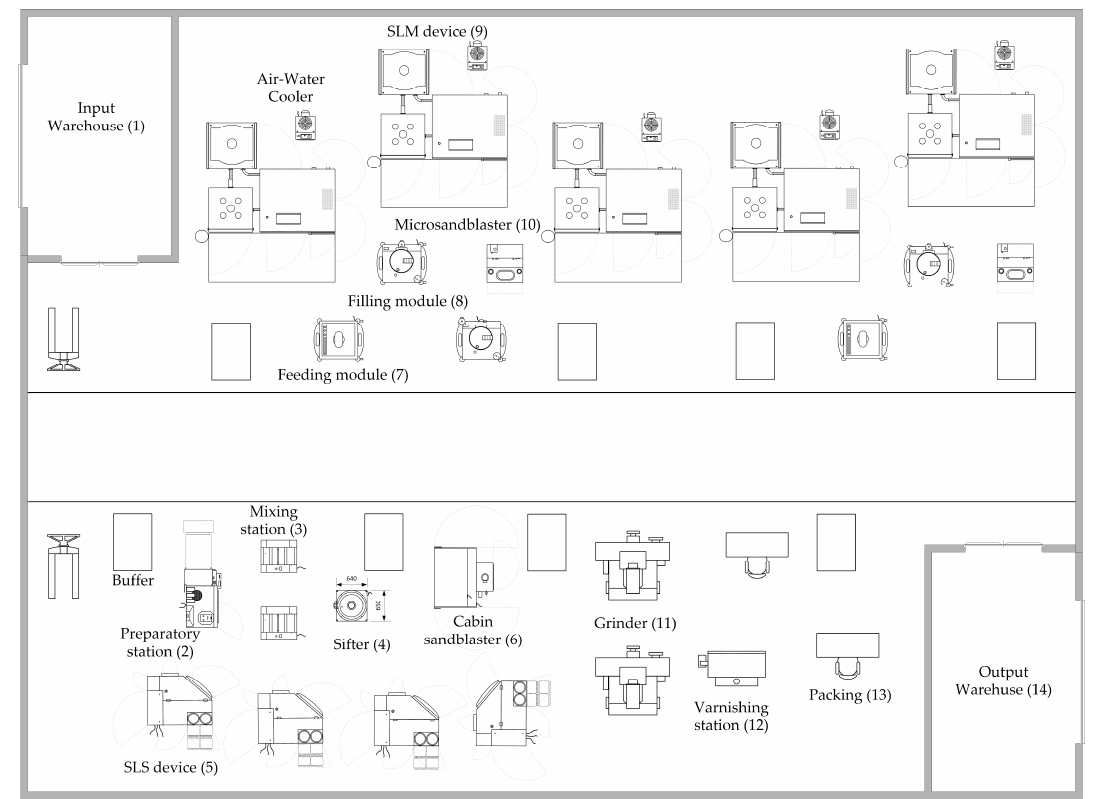
Figure 3. Sample layout plan design for 3D printing machines and devices.